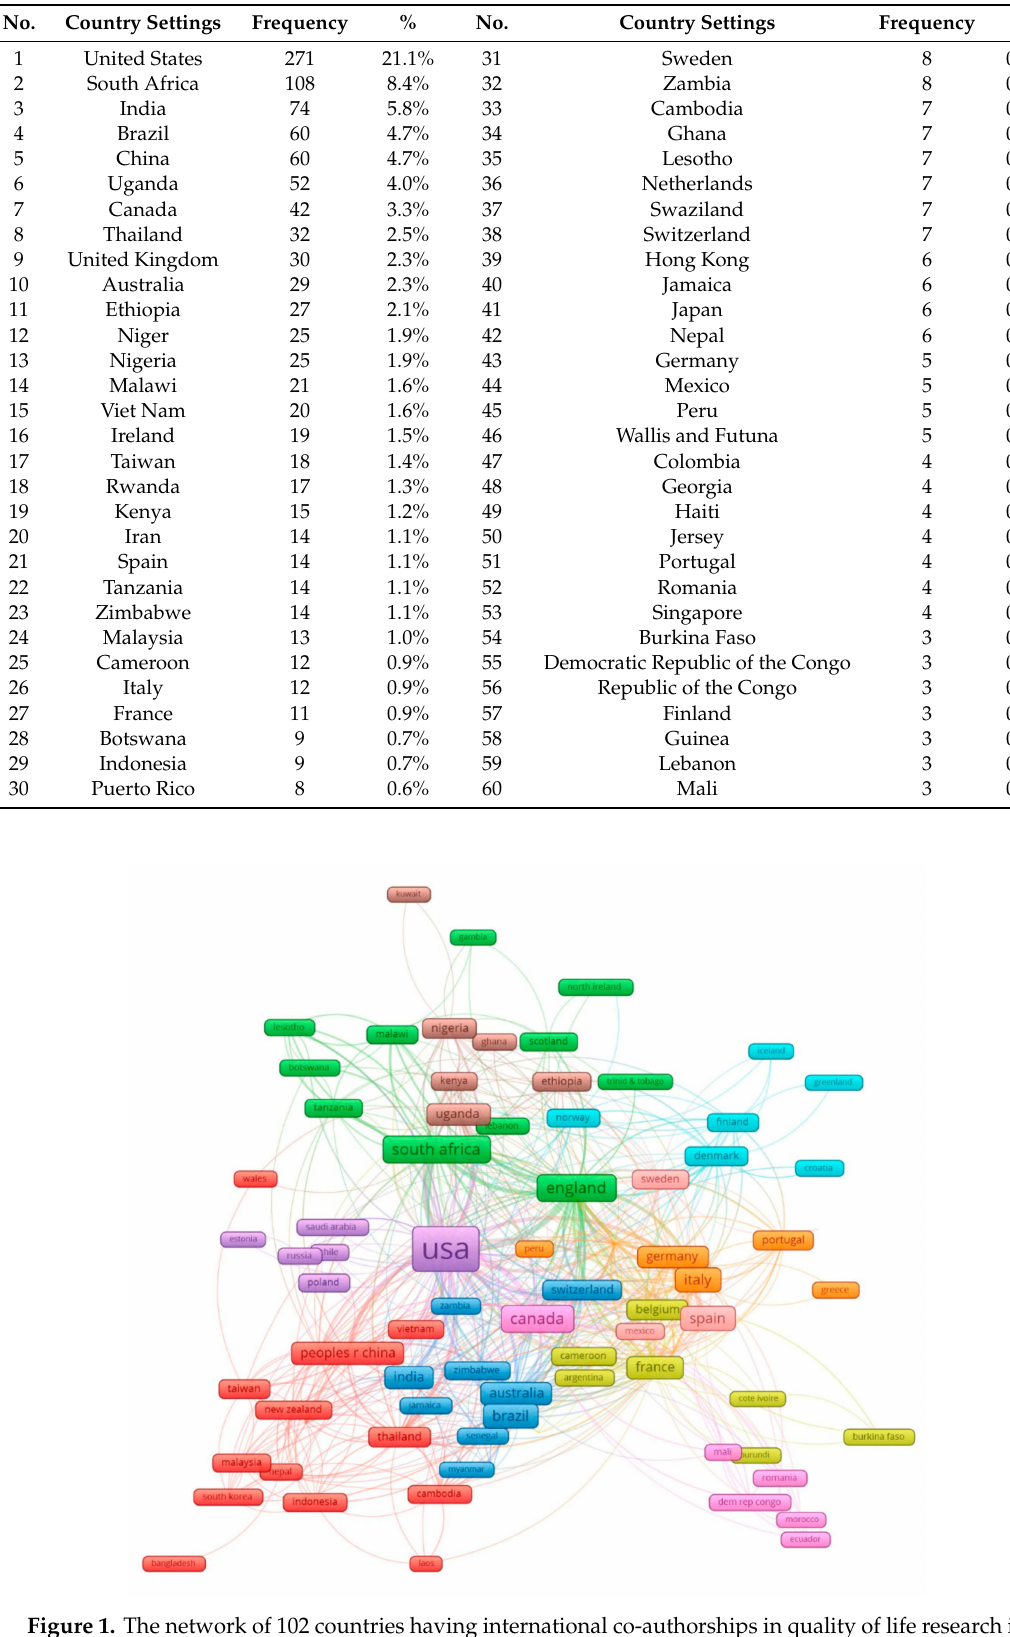
Figure 1. The network of 102 countries having international co-authorships in quality of life research in HIV /